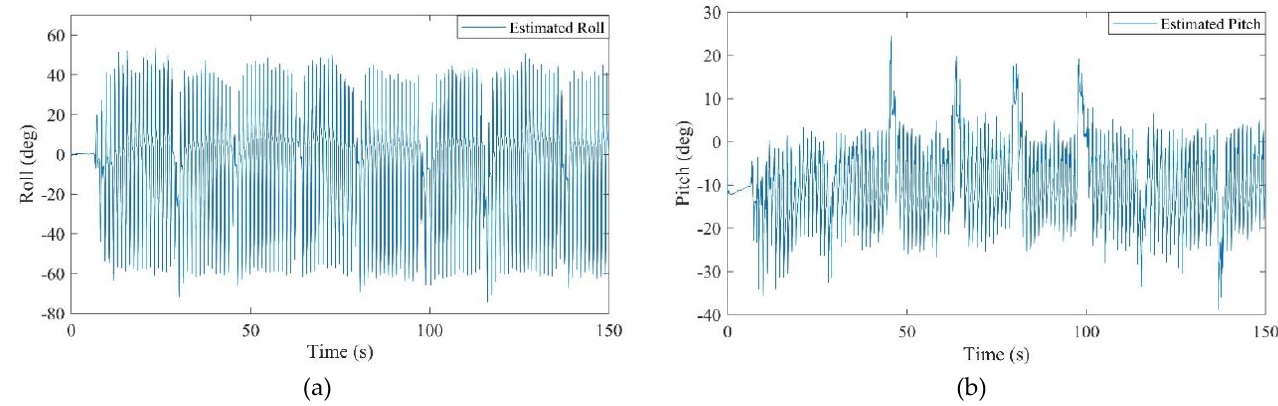
Figure 10. ( a ): Estimated roll angle, ( b ): estimated pitch angle.